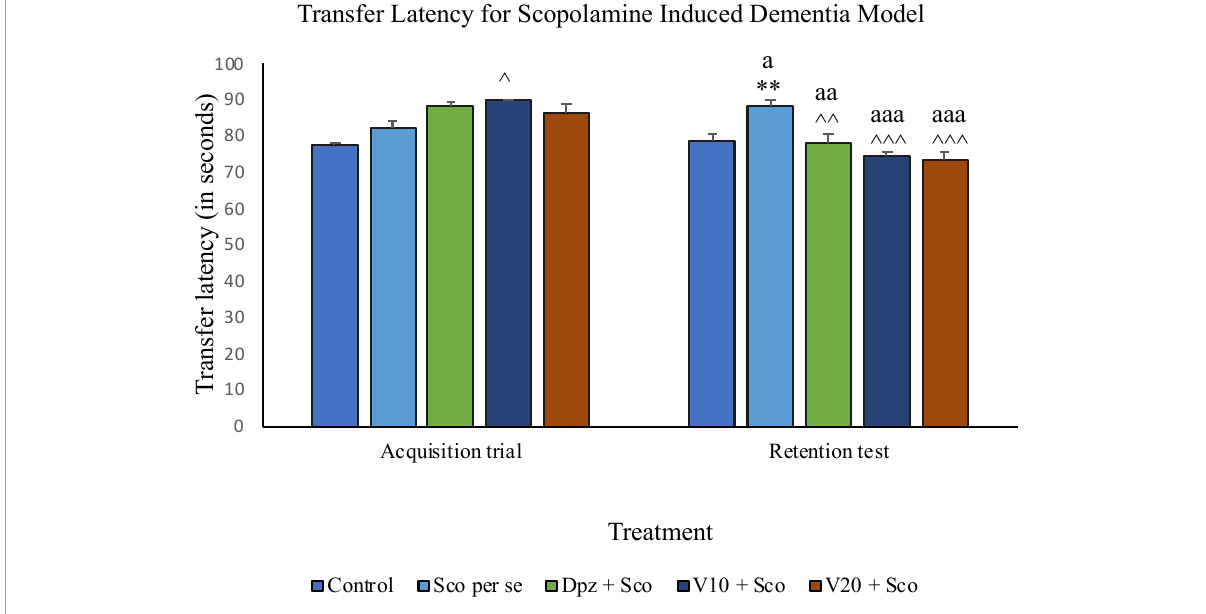
FIGURE14 Effect of vanillin and other treatments on transfer latency. Data are expressed as mean ± SEM. “**” denotes P < 0.01 with respect to the control group within the same day. “ ∧∧∧ ” denotes P < 0.001 with respect to the negative control group (Sco per se ) within the same day. “ ∧∧ ” denotes P < 0.01 with respect to the negative control group (Sco per se ) within the same day. “ ∧ ” denotes P < 0.05 with respect to the negative control group (Sco per se ) within the same day. “aaa” denotes P < 0.001 with respect to the TL of the same group on the 10th day of the treatment, and “aa” denotes P < 0.01 with respect to the TL of the same group on the 0th day of the treatment.